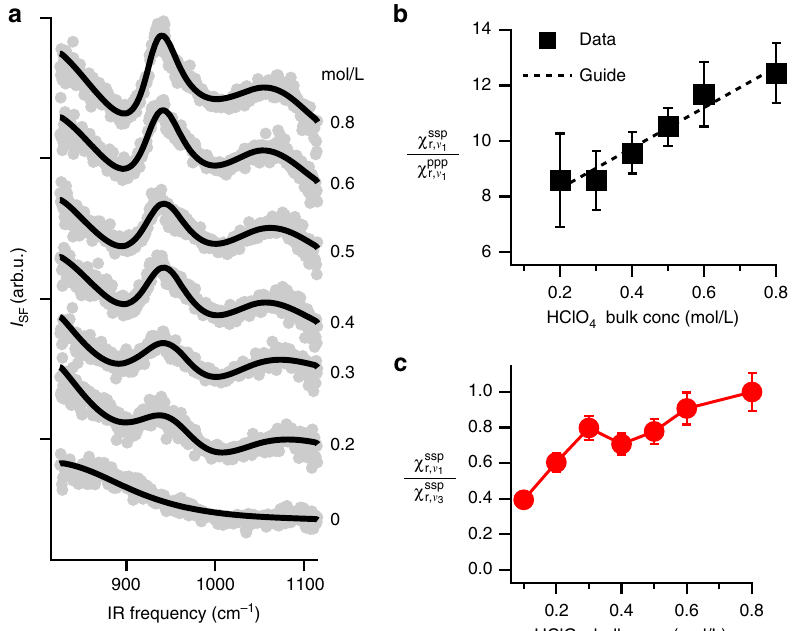
. a VSF spectra as a function of ClO (cid:1) concentration below 1 M for the ssp Fig. 2 The concentration-dependent spectral response of interfacial ClO (cid:1) 4 4 = χ ppp polarization combinations. Grey dots are data and solid black lines the corresponding fi ts. b χ ssp for the data in a and the SI illustrating the linearity of r ; ν 1 r ; ν 1 this ratio with respect to bulk HClO 4 concentration (dotted line is a guide to the eye). The uncertainty at each point is extracted from the fi ts to the data as = χ ssp described in Supplementary Note 1. c χ ssp extracted from the data in a and the SI. This ratio varies by ≈ 50% with change in bulk concentration of r ; ν 1 r ; ν 3 HClO 4 . As we show in Supplementary Note 3 and discuss in the text, changes of this magnitude imply a, concentration dependent, change in interfacial ClO (cid:1) 4 ’ s orientation of less than 5°: the orientation of interfacial ClO (cid:1) 4 is concentration